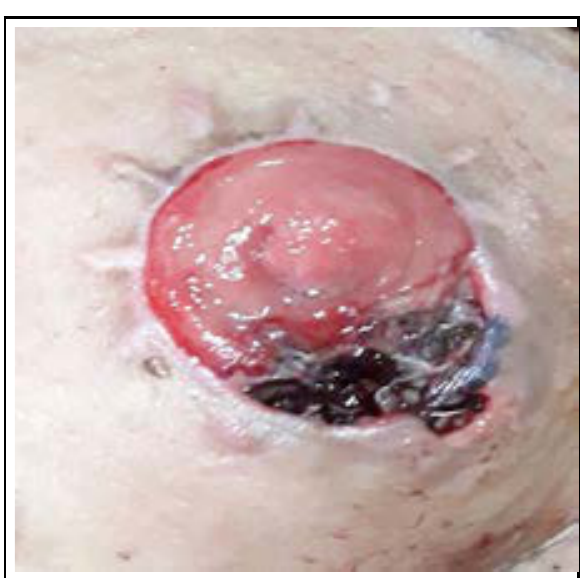
Figure 1. Maggots in the colostomy site at the time of diagnosis Laboratory evaluation showed raised white blood cell count and ESR. Other investigations (biochemical and serological) were normal.